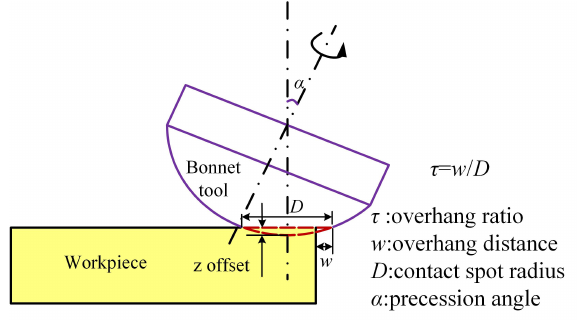
Figure 1. Modeling of the bonnet tool polishing overhanging the edge.